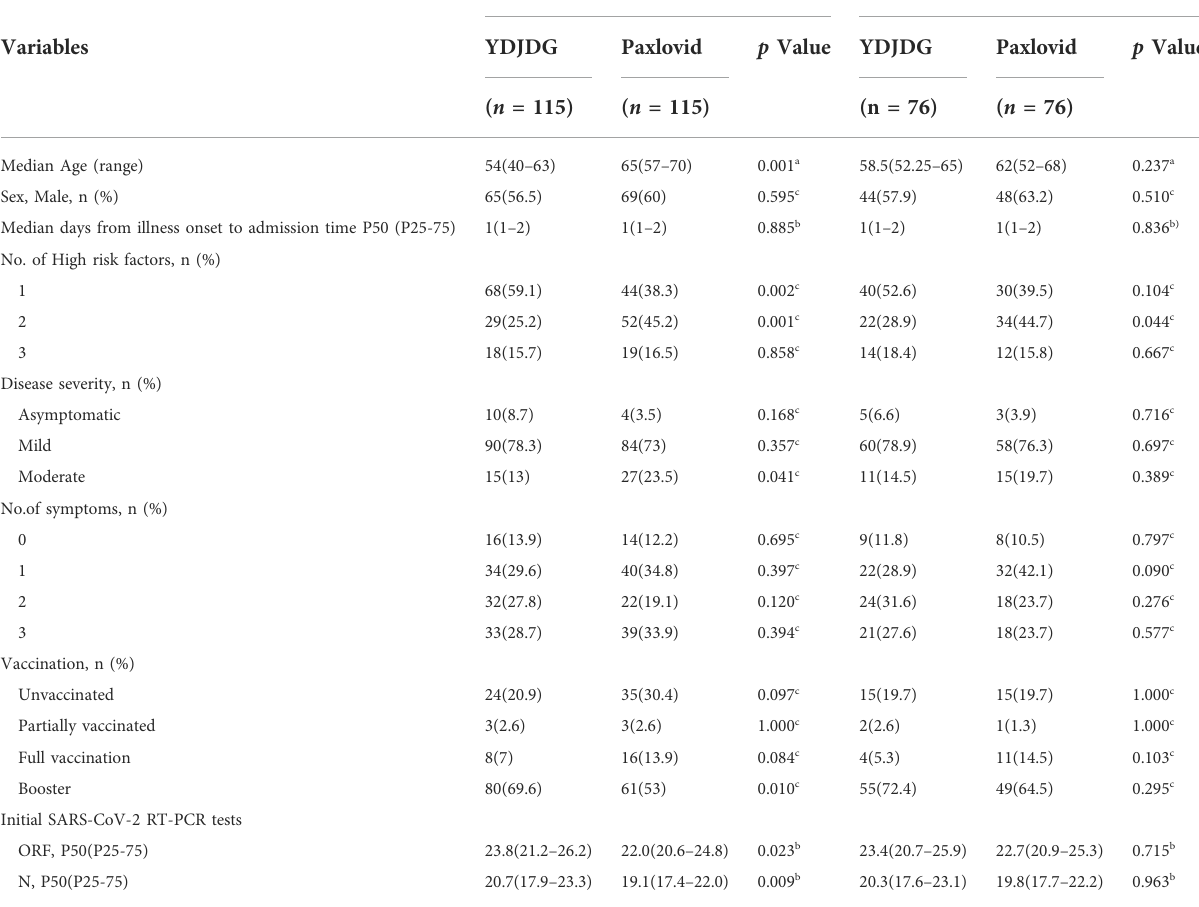
TABLE 3 Baseline characteristics of COVID-19 patients before and after propensity score matching between YDJDG and Paxlovid group. Before propensity score matching After propensity score